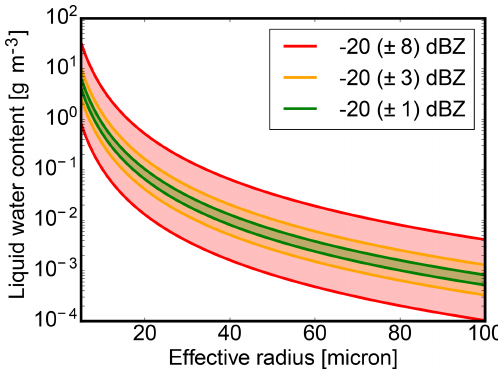
Figure 1. Microphysical retrieval uncertainty due to different abso- lute calibration uncertainties ( ± 1, ± 3, ± 8) for mono-disperse cloud water droplets according to Mie